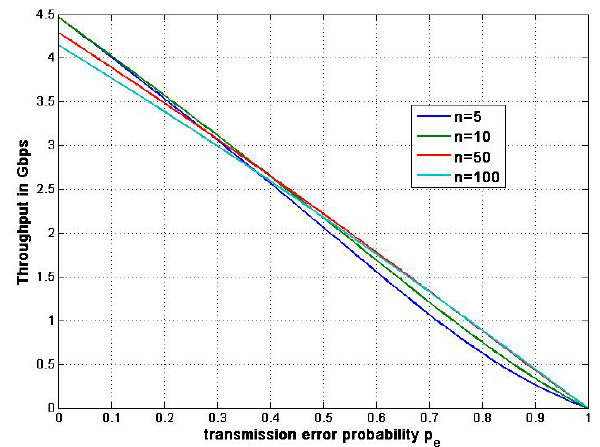
Figure 5. Throughput vs. Transmission error